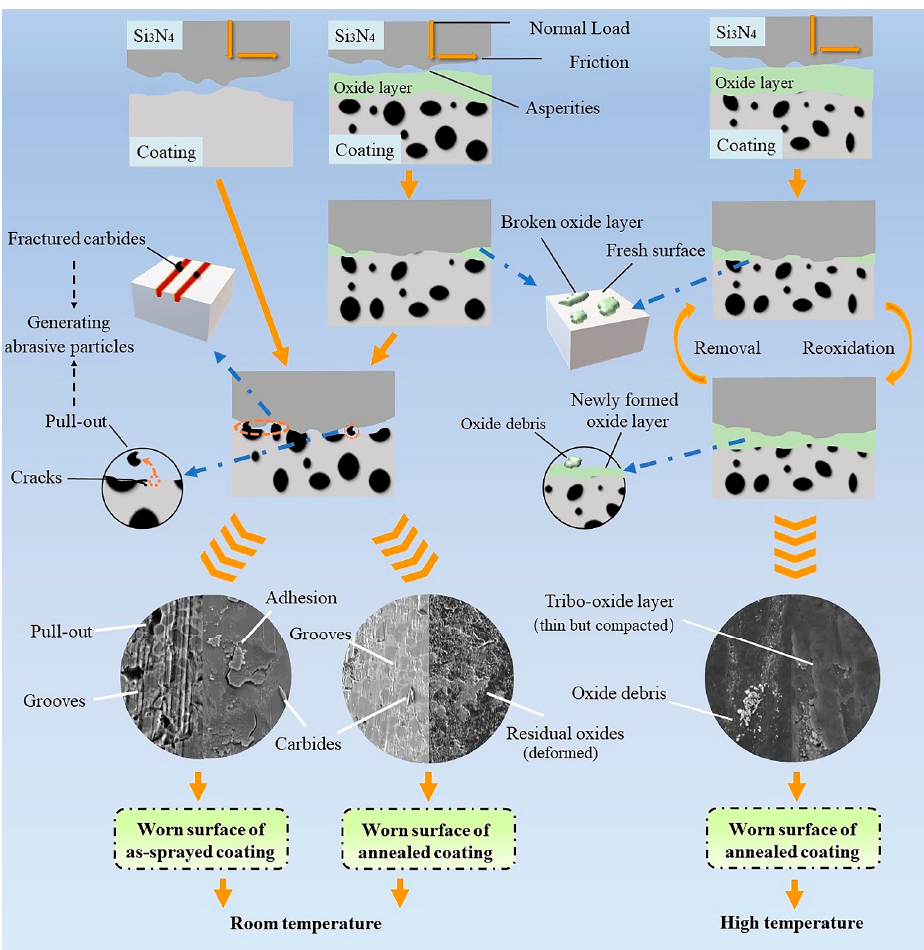
Figure 14. Schematic of wear mechanism of coatings at RT and at 600 °C.